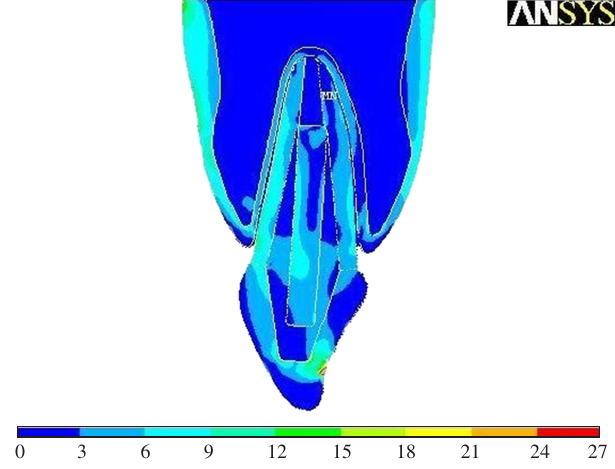
Figure 6. Von Mises equivalent stresses (MPa) in Model